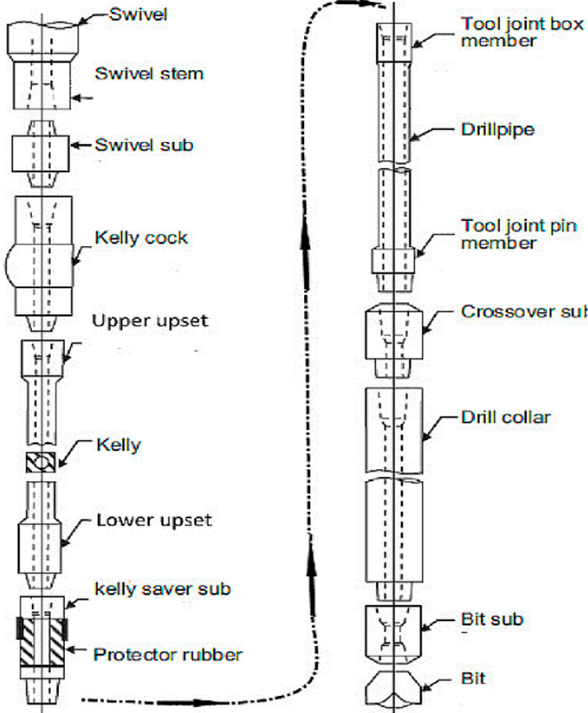
Figure 1. Drill string composition in a rotary drilling system [24].